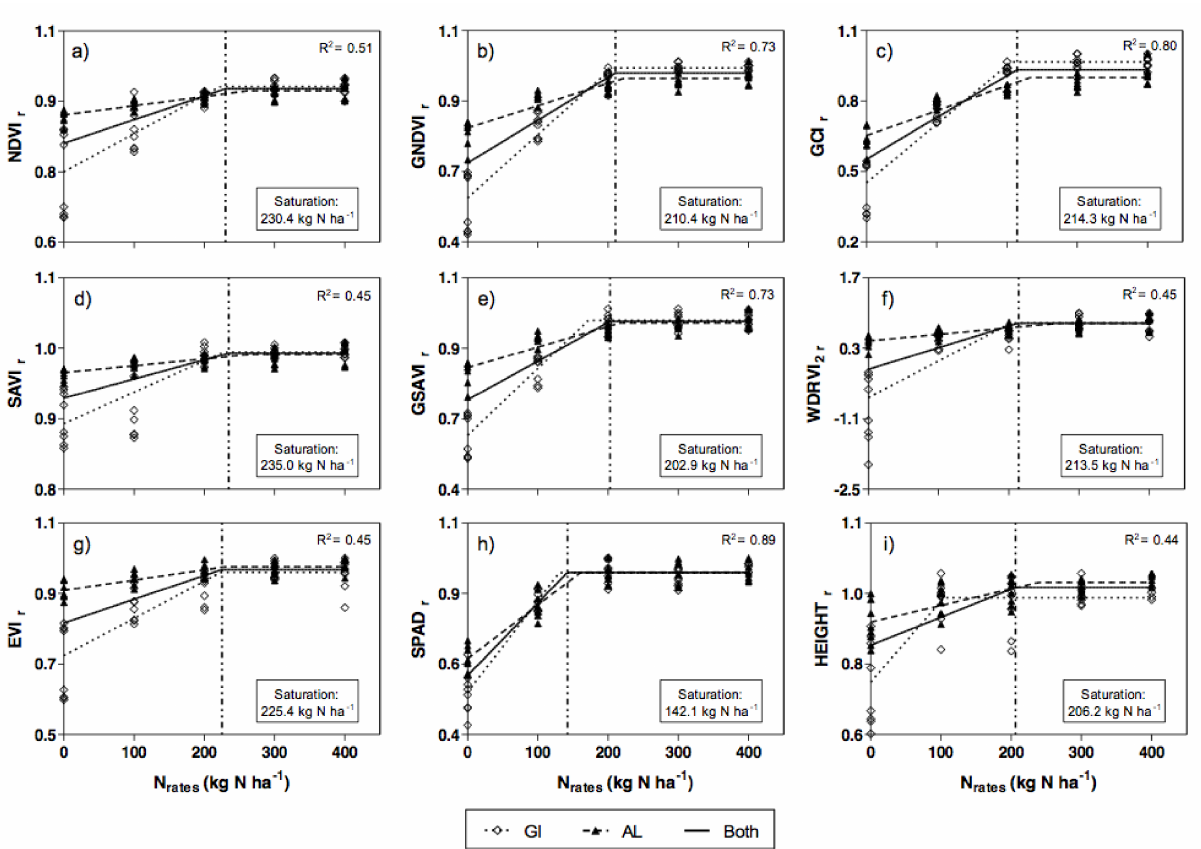
Figure 2. Response of ( a ) NDVI, ( b ) GNDVI, ( c ) GCI, ( d ) SAVI, ( e ) GSAVI, ( f ) WDRVI 2 , ( g ) EVI vegetation indices at V12 stage, ( h ) SPAD and ( i ) plant height (PltH) at VT stage to different nitrogen rates (N rates ) tested in the experiments. Saturation N dose was determined when there was no response to higher N fertilization. The results of Almacelles (AL) and Gimenells (GI) are presented as ratios dividing the indices values by the maximum observed in each year. ‘Both’ indicates that the two fields were analyzed